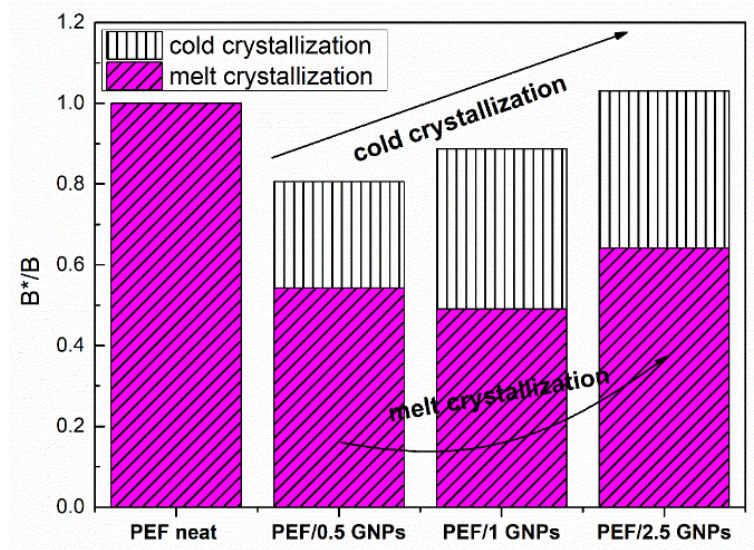
Figure 7. Nucleation activity of the neat PEF and PEF/GNPs nanocomposites, calculated by the Dobreva plots.